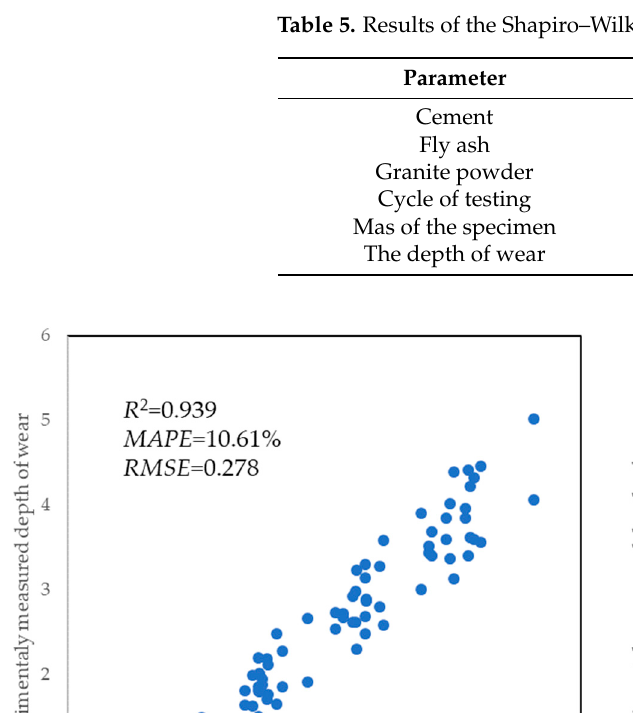
Table 5. Results of the Shapiro–Wilk test.